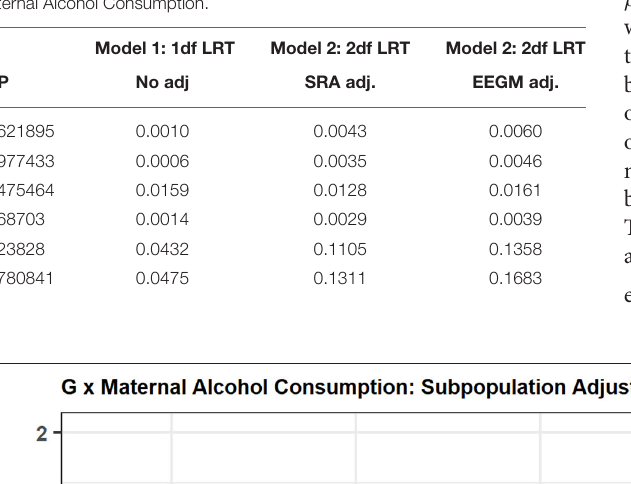
Frontiers in Genetics |